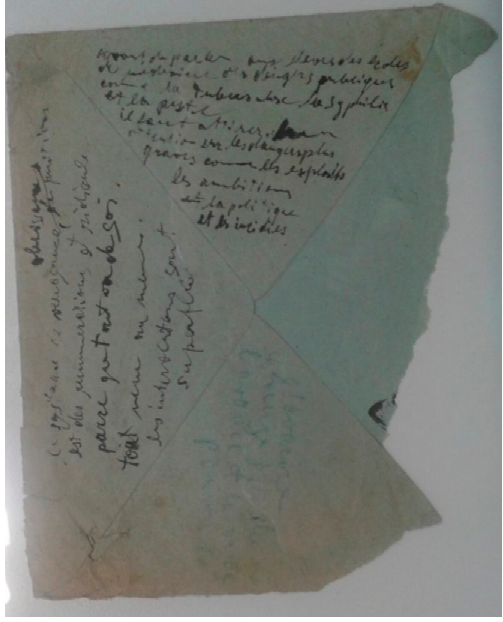
Figure 7. Dieulefit, 1941–1944, Archives Wols, fund Iliazd 3878. Bibliothèque Kandinsky/MNAM. © Adagp, Paris, 2020/Courtesy Bibliothèque Kandinsky.